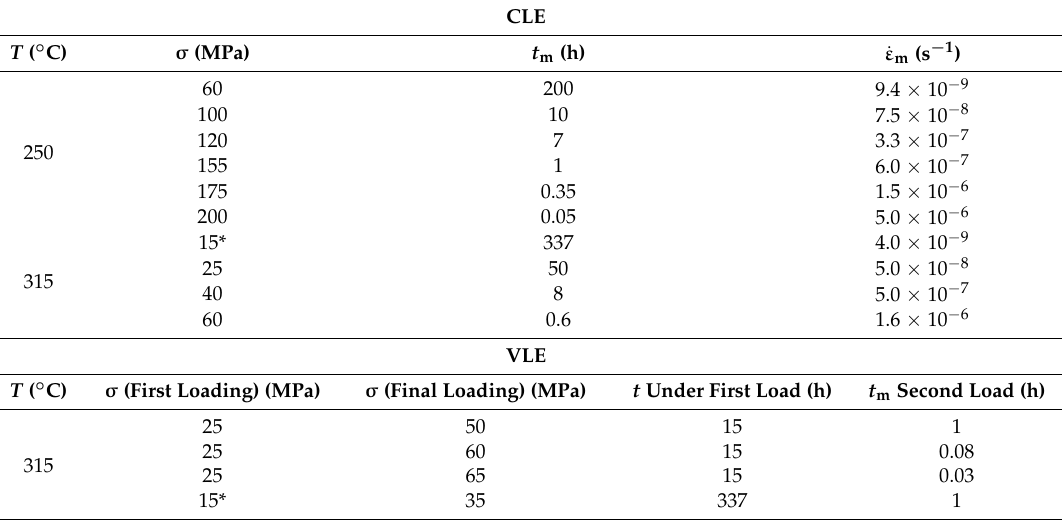
Table 1. Creep data for the CLE and